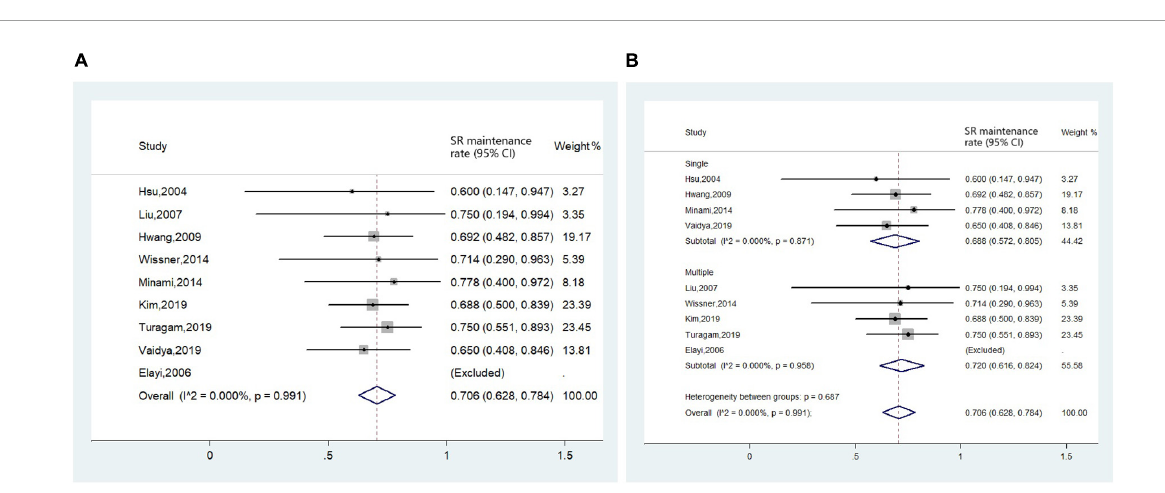
acceptable considering the pooling data. The most specific risk carried with ablation inside PLSVC is left phrenic nerve (LPN) injury. As LPN descends along the anterolateral aspect of PLSVC, injury of LPN should be watched out for when ablating at an anterolateral site, especially in the mid-to-distal portion of PLSVC (30, 31). Pacing at the maximal output through the ablation catheter should be performed to confirm that